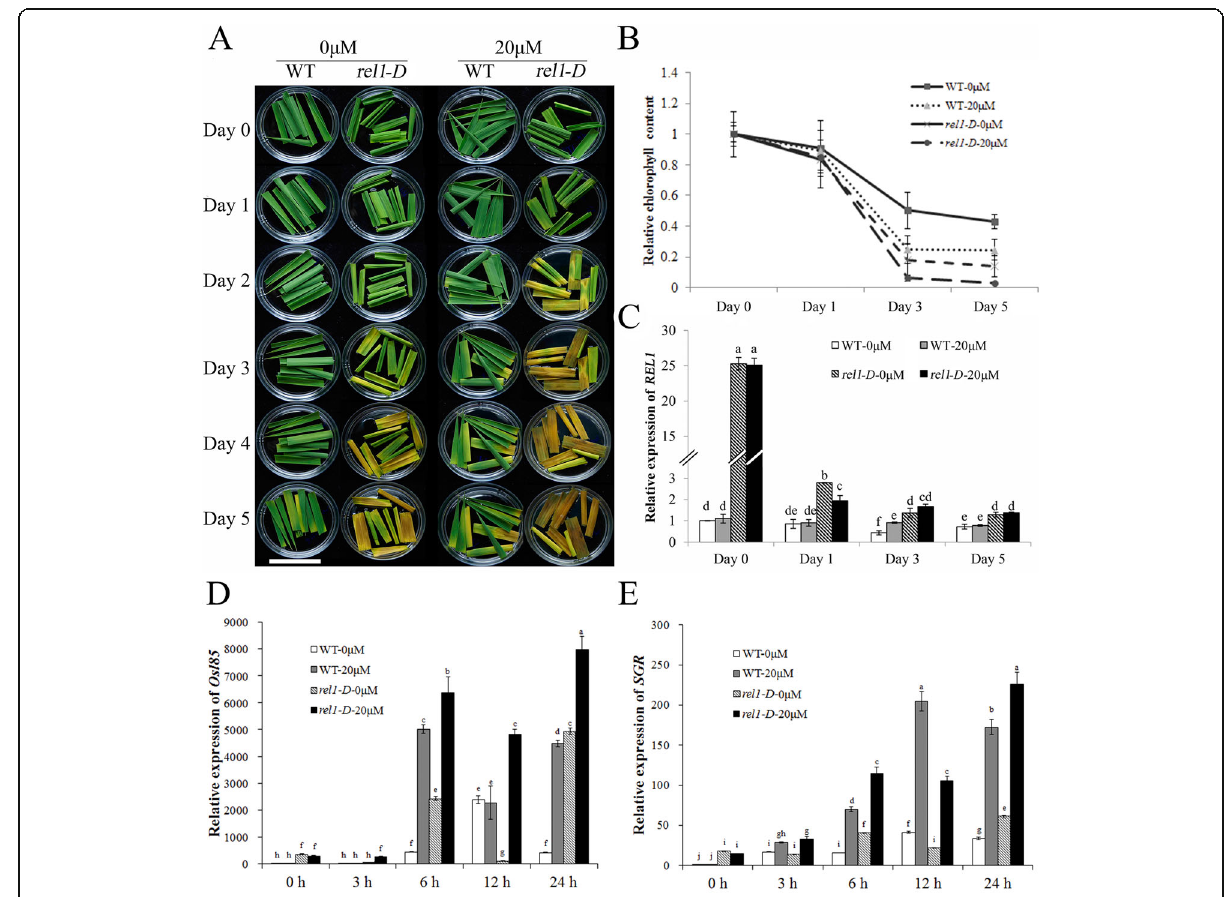
Fig. 2 Response of rel1-D to ABA. a , Response of rel1-D to ABA during dark-induced leaf senescence. Leaves from 1-month-old seedling of WT and rel1-D were incubated with 20 μ M ABA for 1 to 5 days, bars = 5 cm. b , Chlorophyll content of WT and rel1-D by ABA treatments. c , Expression of REL1 in response to ABA treatment. d , Expression of Osl85 in response to ABA treatment. e , Expression of SGR in response to ABA treatment. B- E, Data were presented as mean ± S.E.. c - e , Multiple comparisons, Duncan, p -value <